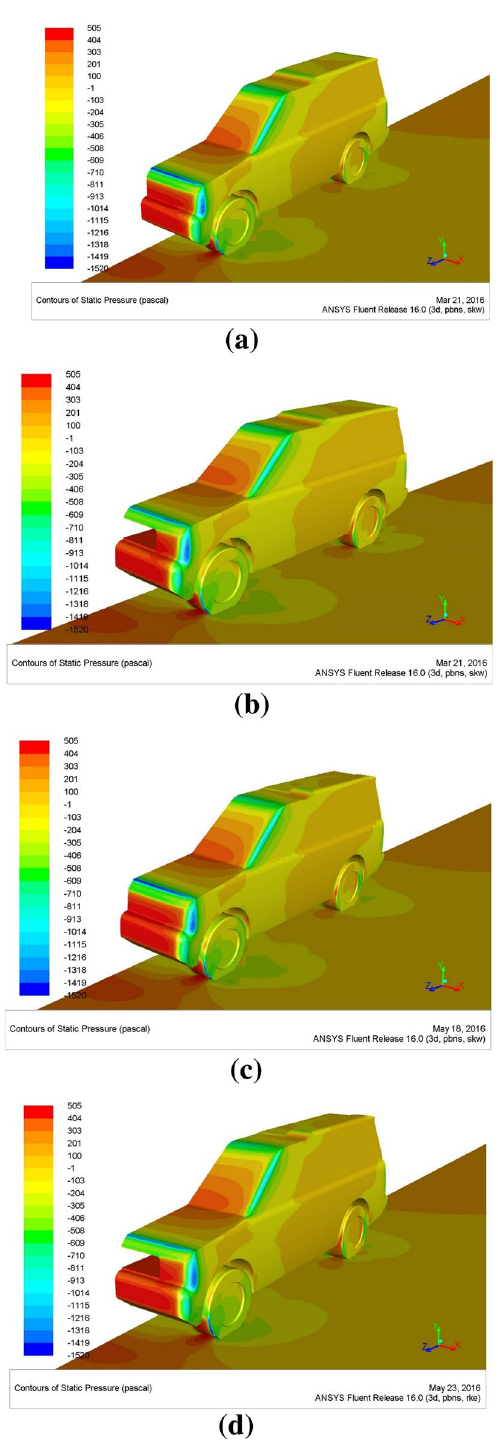
Figure 17. (a) Contours of pressure for the baseline of the Land Rover Discovery. (b) Contours of pressure for the Land Rover Discovery with the ventilation duct. (c) Contours of pressure for the Land Rover Discovery with roof modification. (d) The ventilation duct and roof modification contain pressure for the Land Rover